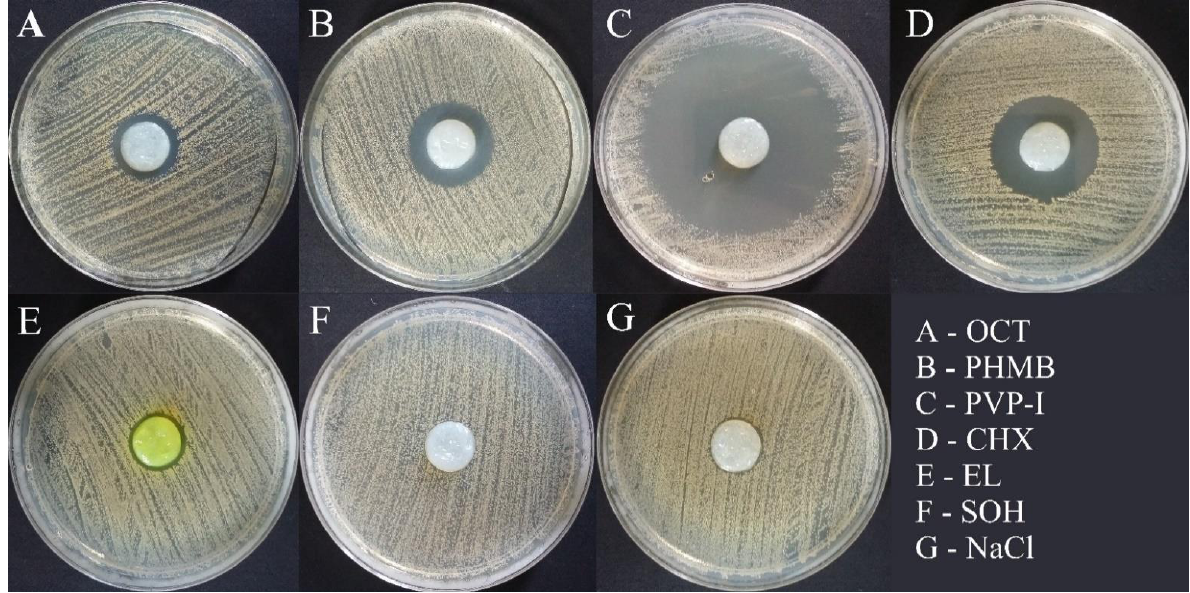
Figure 11. Growth inhibition zones around bacterial cellulose dressing are chemisorbed with the tested compounds. OCT—octenidine dihydrochloride, PHMB—polyhexanide, PVP-I—povidone-iodine, CHX—chlorhexidine, EL—ethacridine lactate, SOH—super-oxidized hypochlorites solution, NaCl—Sterile saline as a negative control. The picture shows results for the Staphylococcus aureus ATCC 33591 reference strain.